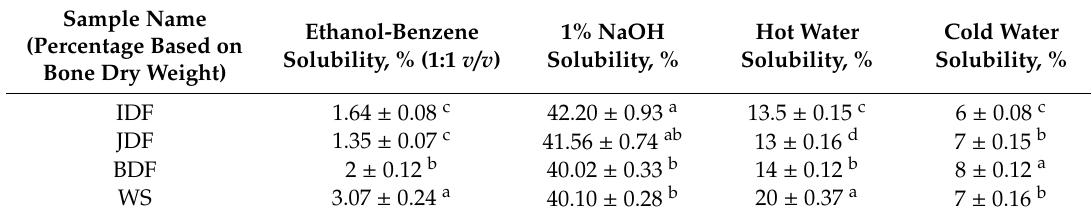
Table 4. Chemical composition of animal dung fiber and